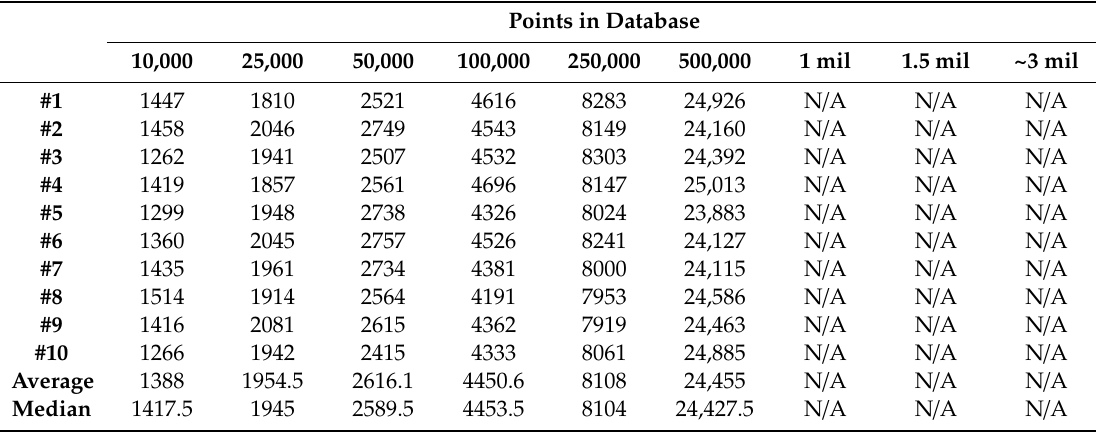
Table 3. Results of testing OpenLayers library (values in